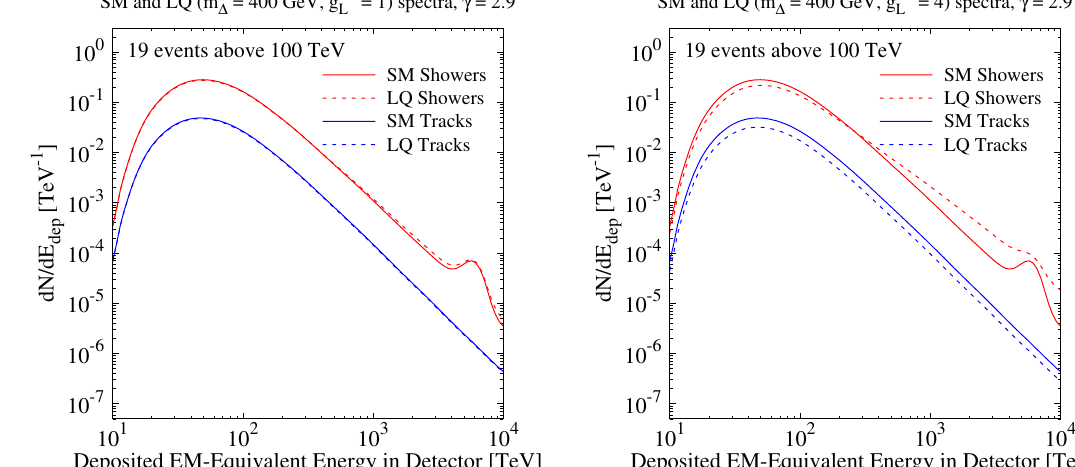
Figure 10 . Comparison between the distribution of shower and track events for the SM and two representative LQ scenarios: m (cid:1) = 400 GeV and g c(cid:28) and g c(cid:28) = 4 (right panel). Notice that the LQ shower (and track) distributions include both the L contribution of the SM as well as of the LQ